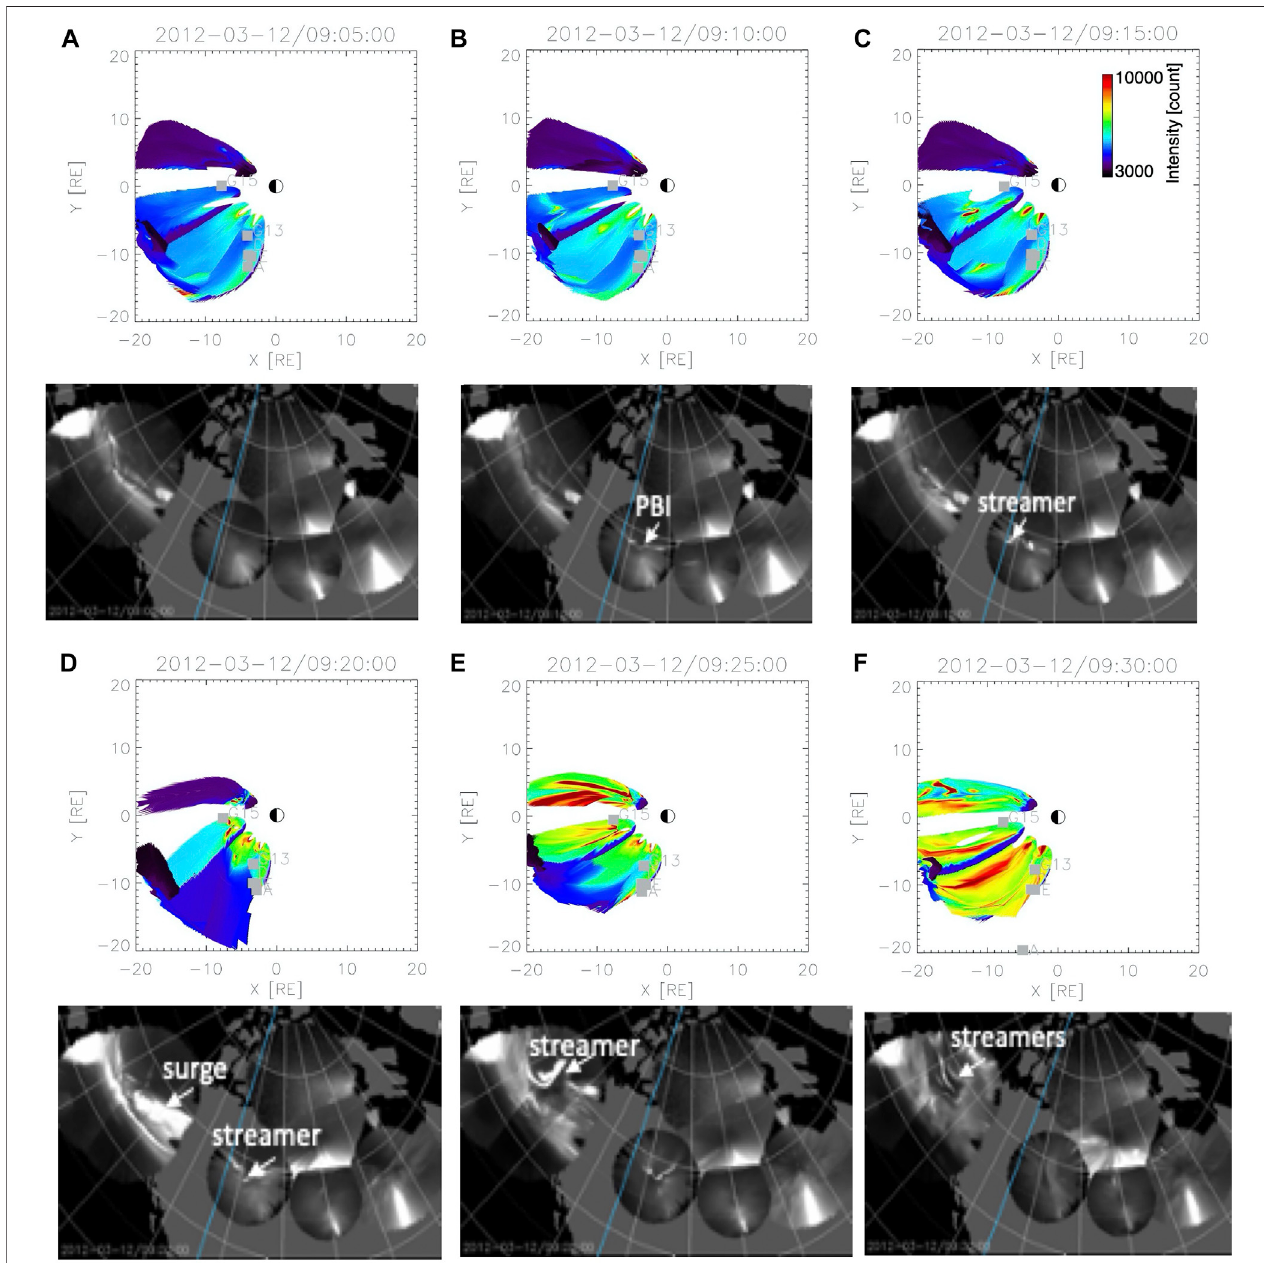
FIGURE 3 | THEMIS ASI auroral images mapped to the GSM equatorial plane using TS01 (top) and globe projections (bottom) for 9:05 – 9:30 UT. The colorbar in panel (C) applies to all panels. Symbols indicate the mapped location of the GOES 13 (G13), GOES 15 (G15), and THEMIS (A, D, E) satellites.